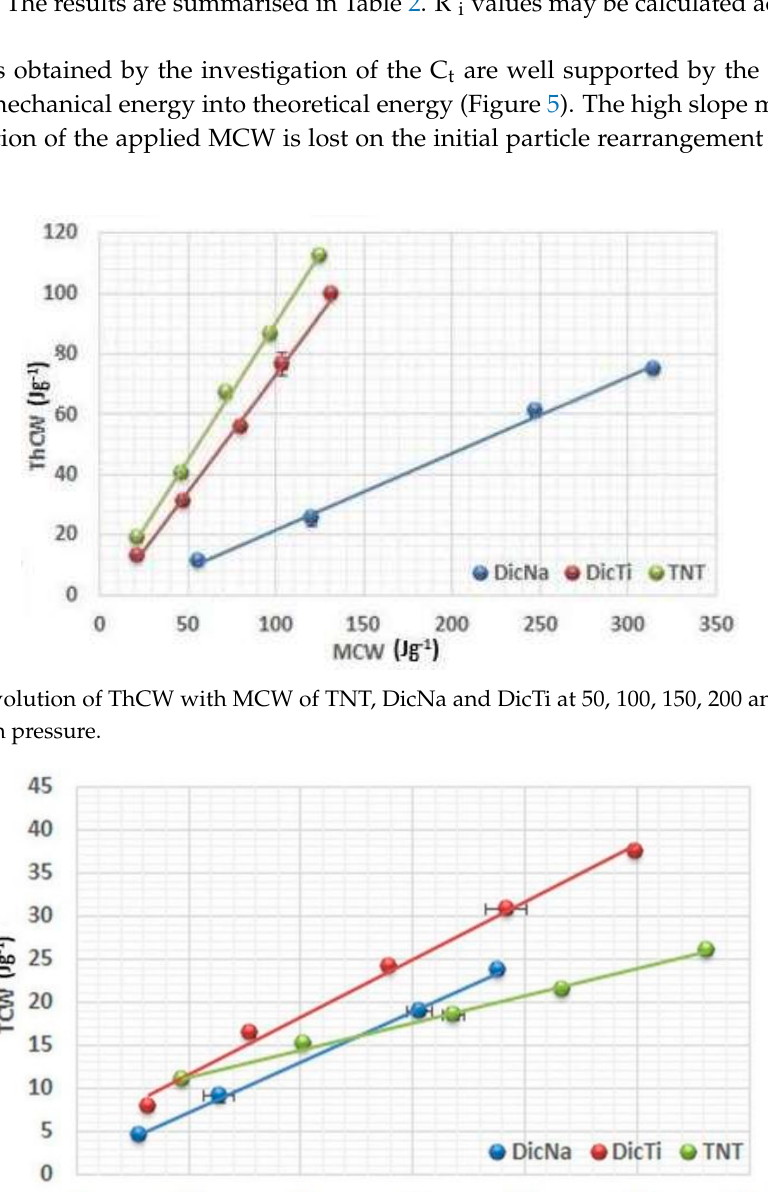
Figure 4. General diametral rupture curve of DiltTi compressed with 100 MPa. Table 2. Energetic parameters of titanate nanotubes (TNTs), active pharmaceutical ingredients (APIs) and TNT–API composite powders.